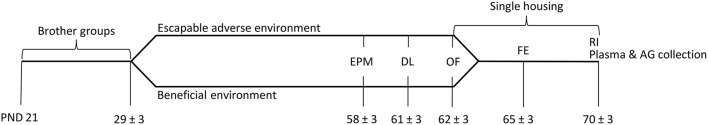
Timeline of experimental design. After weaning at postnatal day (PND) 21, experimental animals lived in brother groups. Starting on PND 29 ± 3, experimental mice either experienced an escapable adverse or a beneficial environment. To assess anxiety-like behavior, the Elevated Plus Maze test (EPM), Dark-Light test (DL), and Open Field test (OF) were conducted. After the OF, the animals were housed singly. On PND 65 ± 3 the Free Exploration test (FE) was performed and on PND 70 ± 3 aggressiveness was determined in a Resident Intruder test (RI). Trunk blood was collected to investigate plasma corticosterone and testosterone levels and adrenal glands (AG) were dissected to determine tyrosine hydroxylase activity.